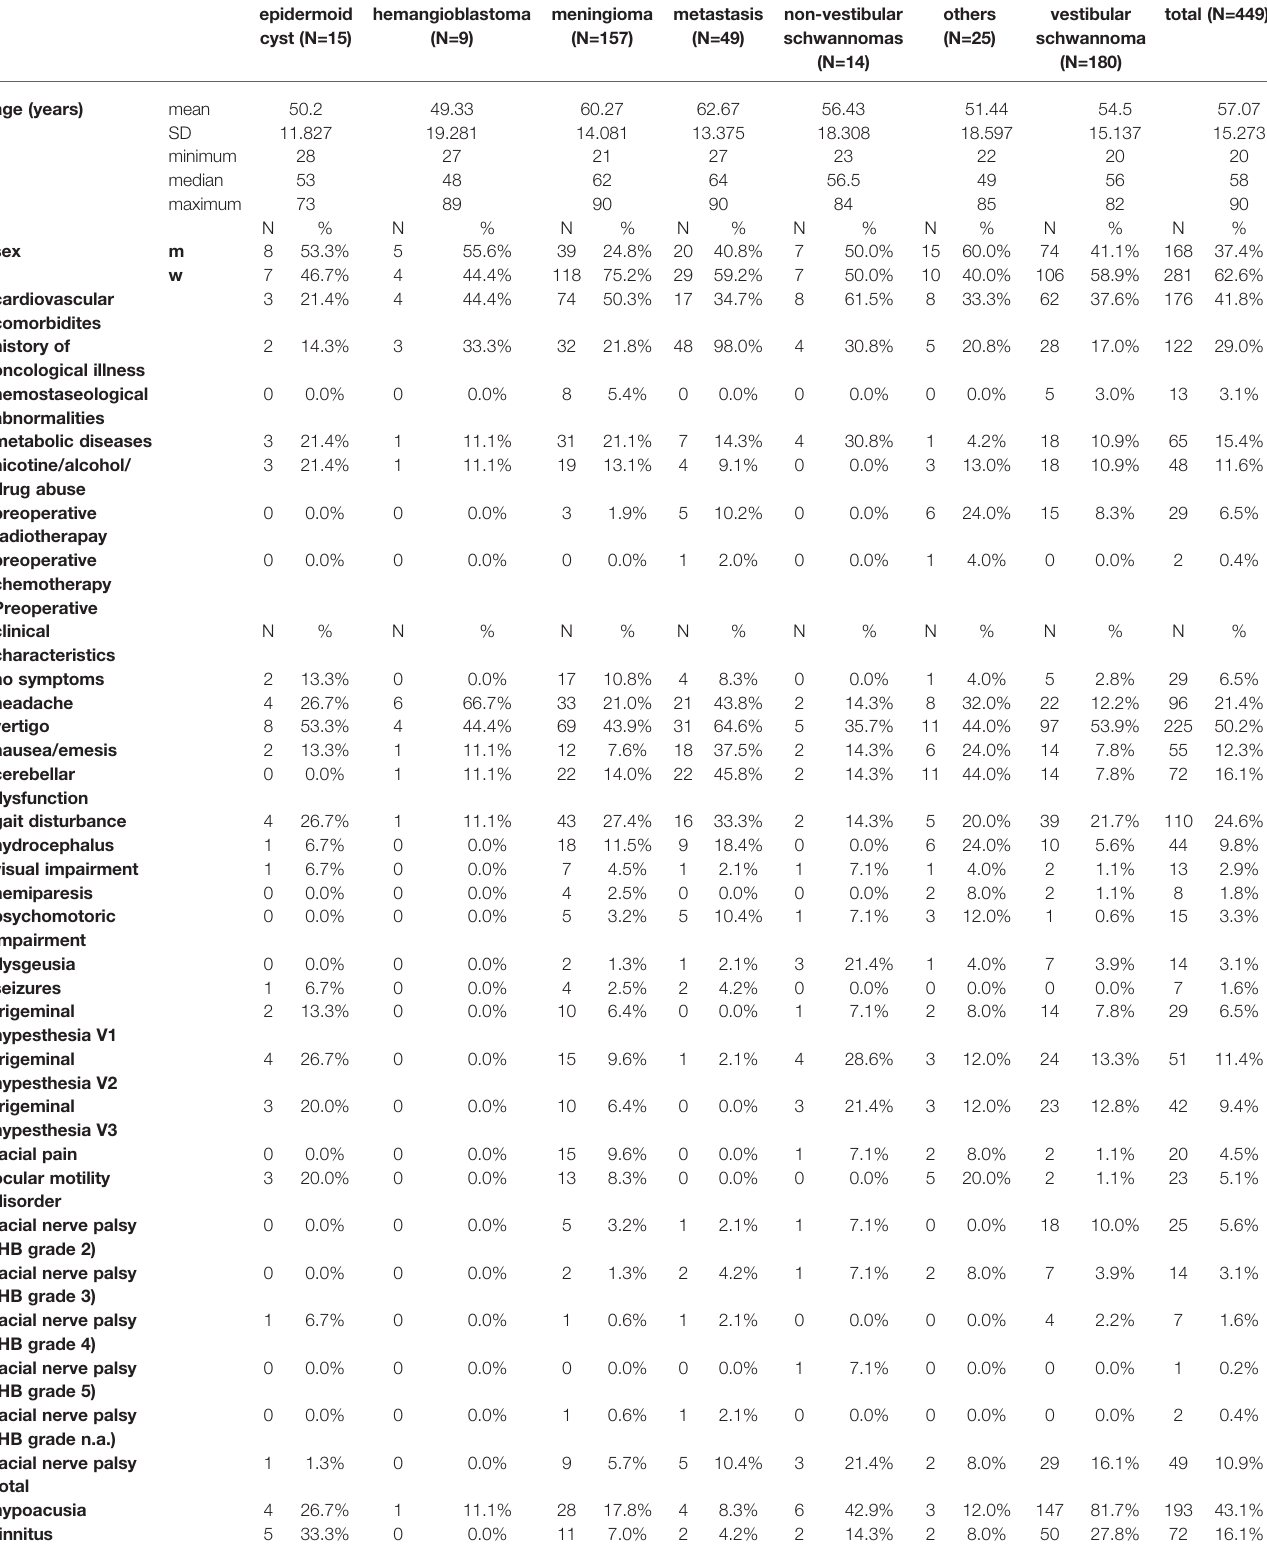
TABLE 1 | Demographics, clinical presentation, and tumor